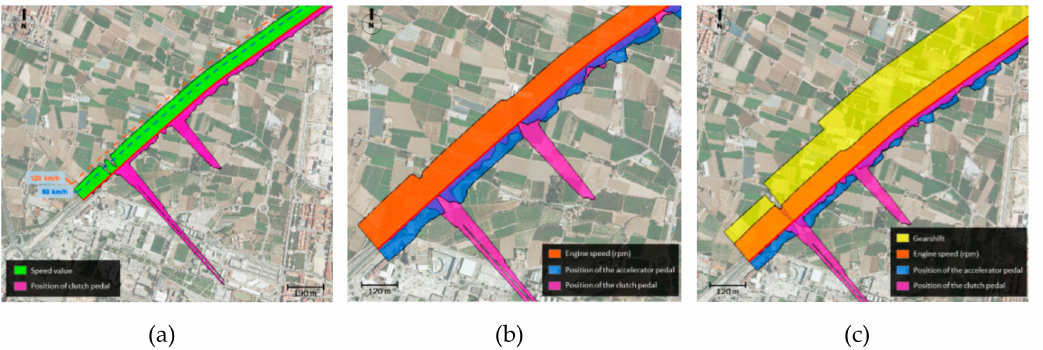
Figure 5. Kinematic driving parameters related to the performance of one subject in study area B. Di ff erent mapping results using geometric and color